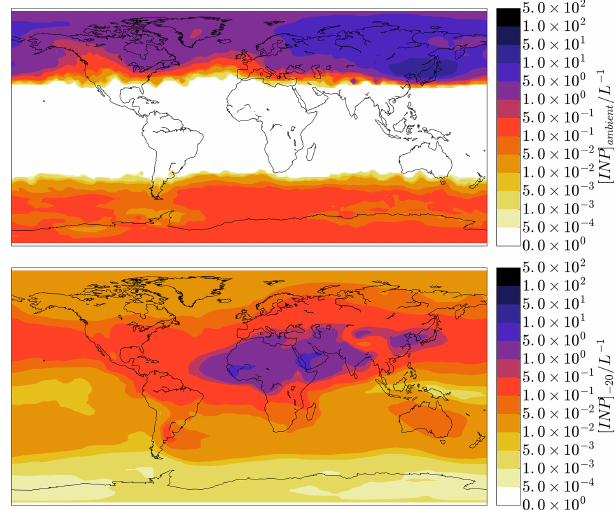
Figure 4. Annual mean K-feldspar INP distribution using GLOMAP mode at a pressure level of 600hpa. Top panel shows the concentration of ice-nucleating particles active at a temperature of − 20 ◦ C ([INP] T ) whereas the bottom panel shows the INP con- centration at local ambient temperature ([INP] ambient